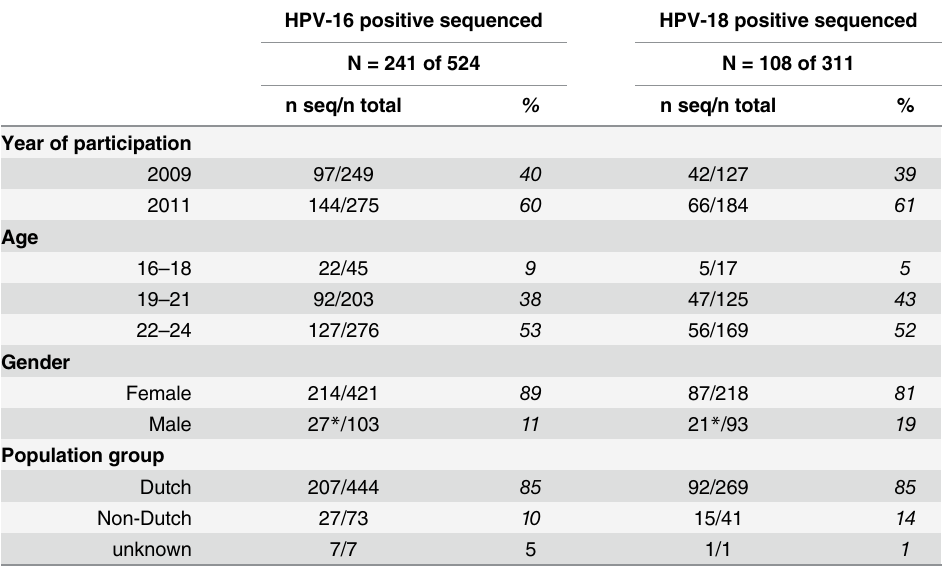
Table 1. Characteristics of study